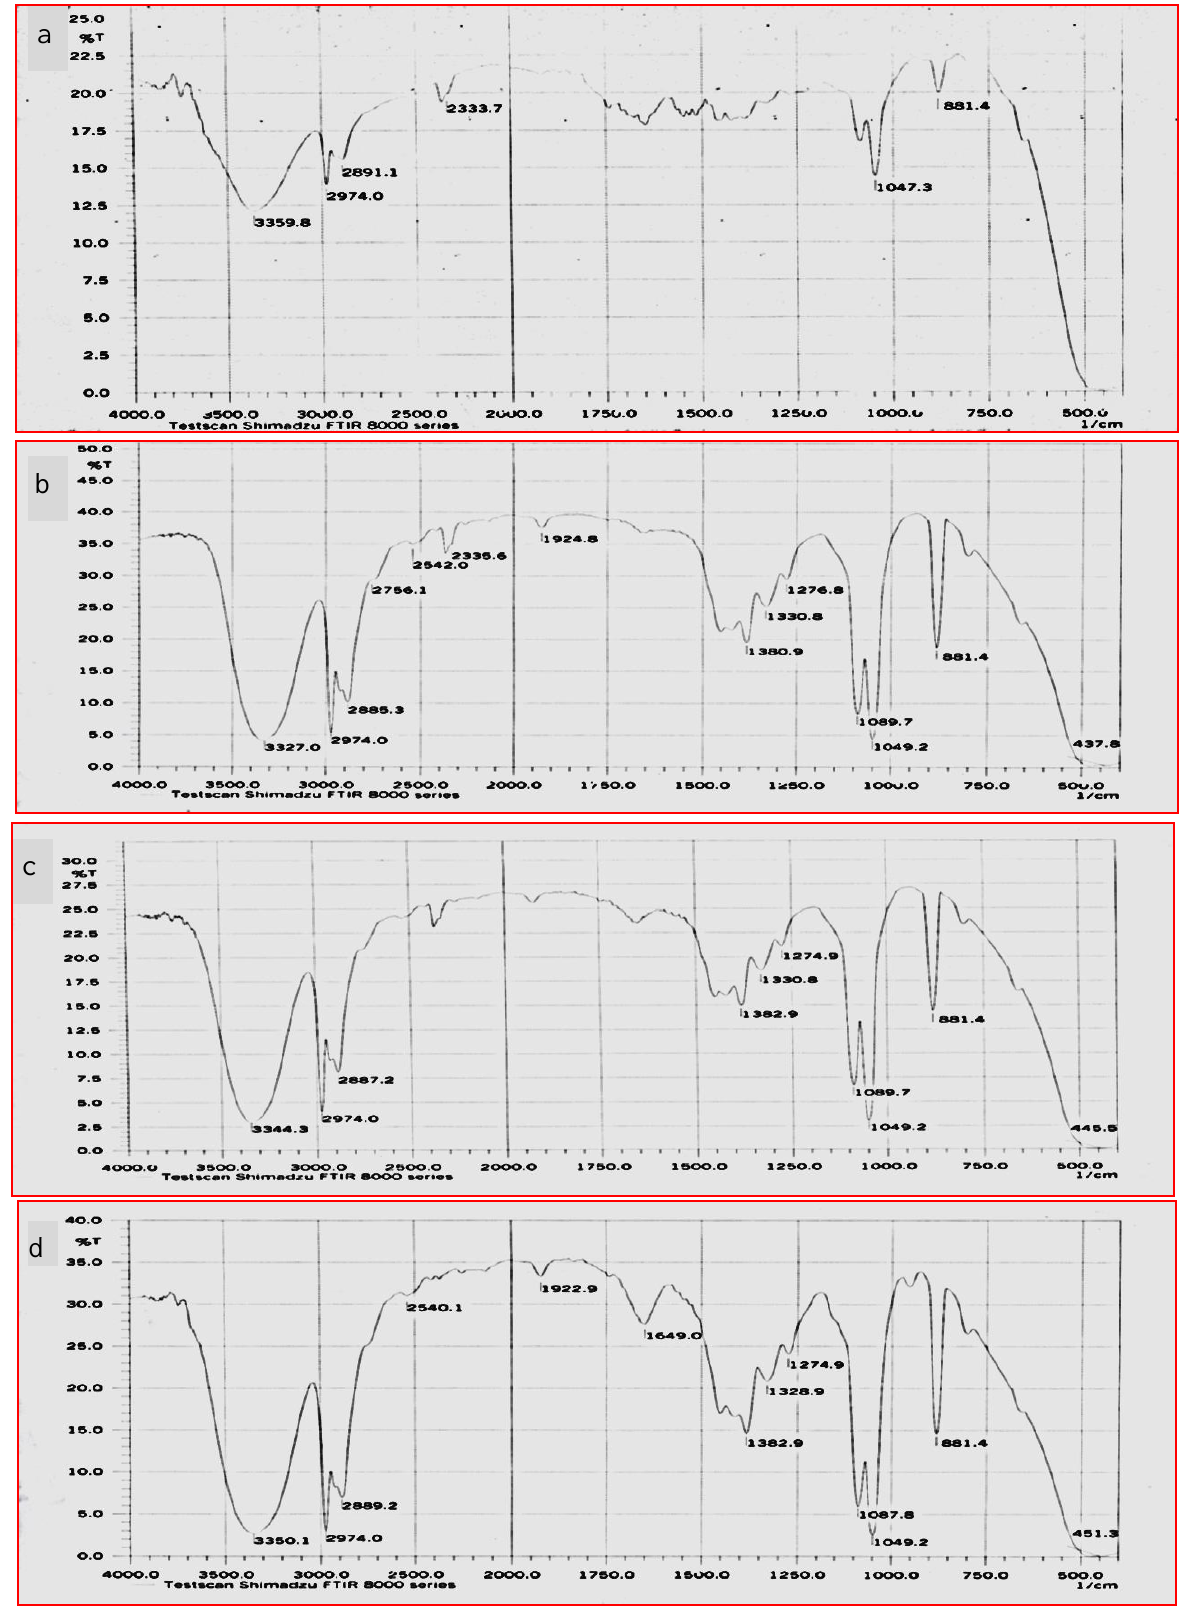
Fig.2: FTIR spectrum of CNPs suspensions produced at different laser energy a) ethanol